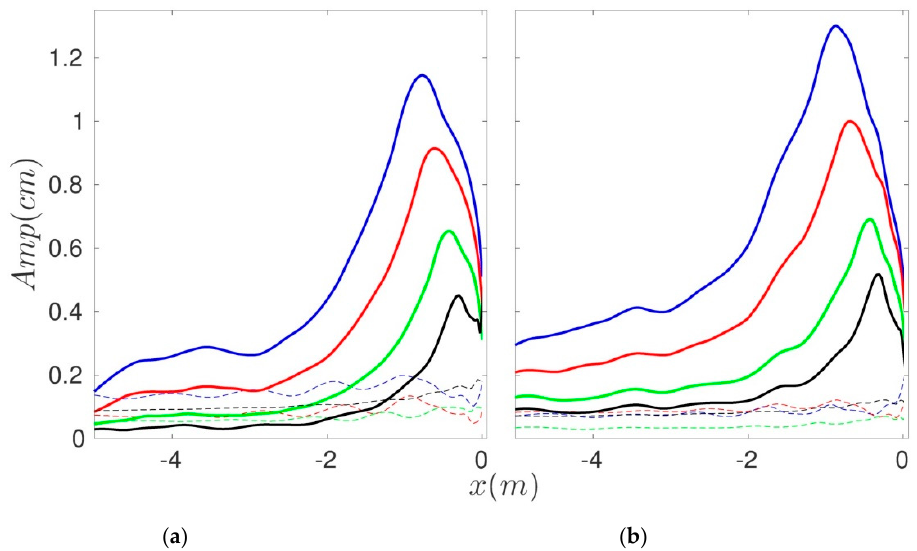
Figure 9. Incident (full lines) and outgoing (dash lines) infragravity surface elevation at f g for bichromatic cases 1055 ( a ), 1060 ( b ) from Baldock et al. [24]. Colours are for different fully modulated wave groups with short wave amplitude 0.05 m (blue), 0.035 m (red), 0.025 m (green) 0.015 m (black).